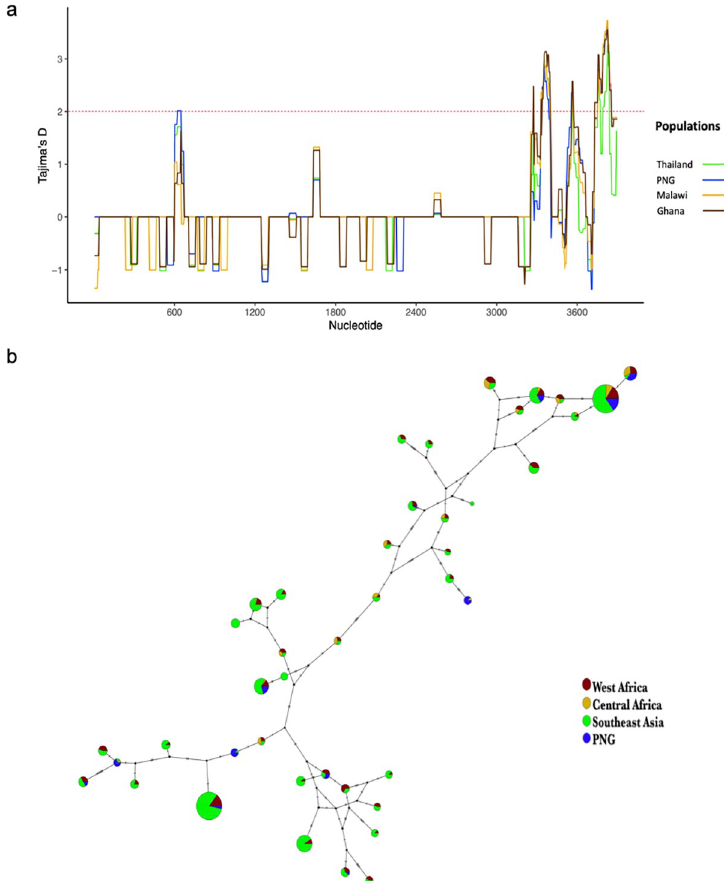
Fig 4. Global diversity of clag8 . a) Tajima’s D along the clag8 gene in samples from Thailand, PNG, Malawi, and Ghana. The dotted red lines represent a positive Tajima’s D value ( � 2), suggestive of balancing selection. b) Haplotype network of clag8 using P . falciparum sequence